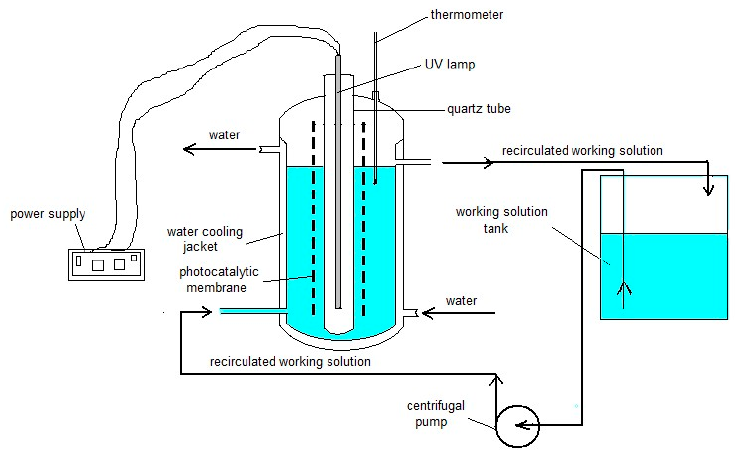
Figure 10. The simplified scheme of the photocatalytic reactor.